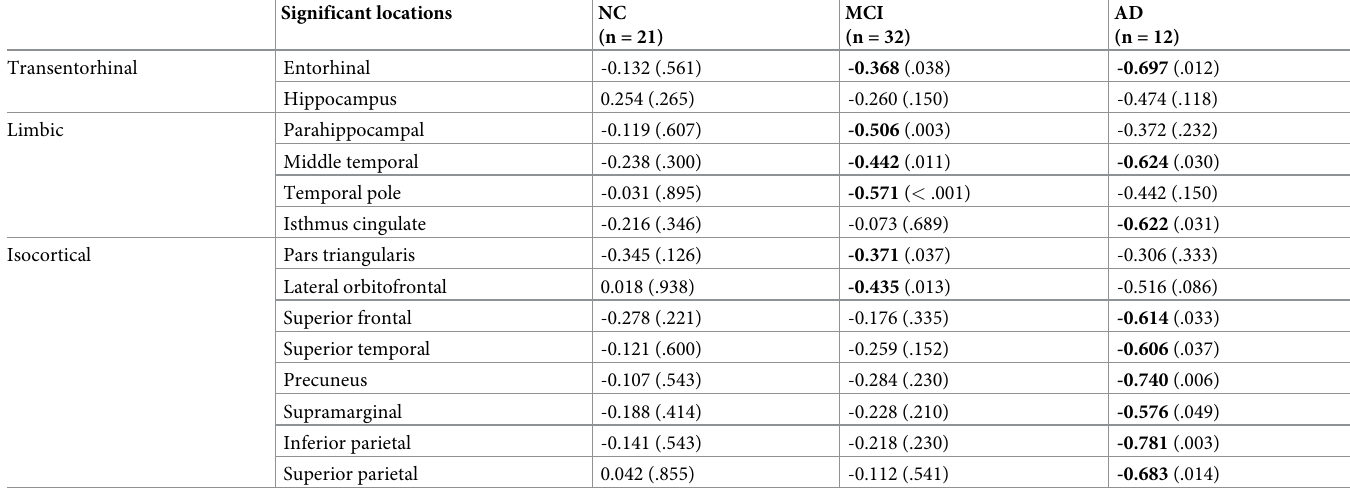
Table 2. Comparison of locations showing correlations between THK-5351 uptake and cortical volume, demonstrated with in vivo Braak composite locations across the Alzheimer’s disease